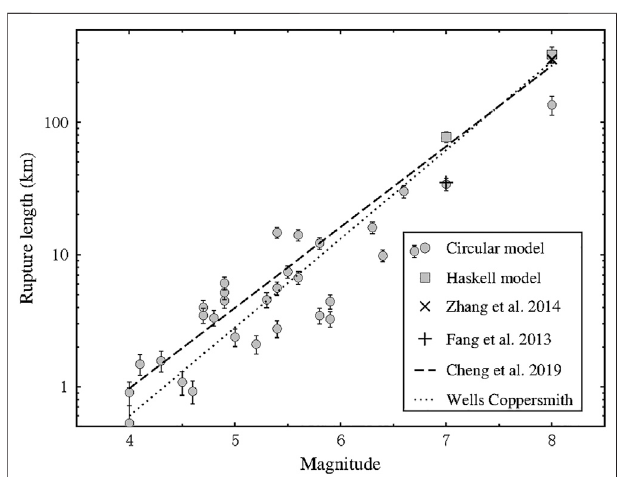
FIGURE 10 | The scaling relationship between the predicted rupture length and M . The circles and the squares are the predicted rupture length from circular model and Haskell model, respectively. The dashed line is the linearregressionrelationshipinmainlandChinacalibratedbyChengetal. (2019). The dotted line represents the relationship proposed by Wells and Coppersmith (1994). The diagonal cross and cross are the results of M 8.0 Wenchuan earthquake by Zhang et al. (2014) and M 7.0 Lushan earthquake by Fang et al. (2013), respectively. The estimated errors computed through the error propagation theory are shown by the vertical error